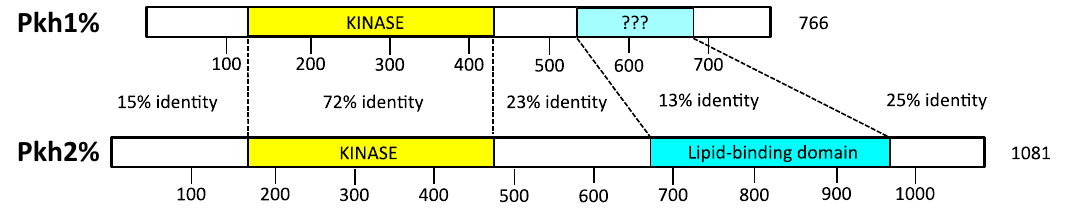
Figure 3. Comparison of Pkh1 and Pkh2. Catalytic domain (yellow), N- and C-terminal extensions (white) and position of a putative lipid-binding domain (blue) characterized in Pkh2 only [70–72] are only indicated.